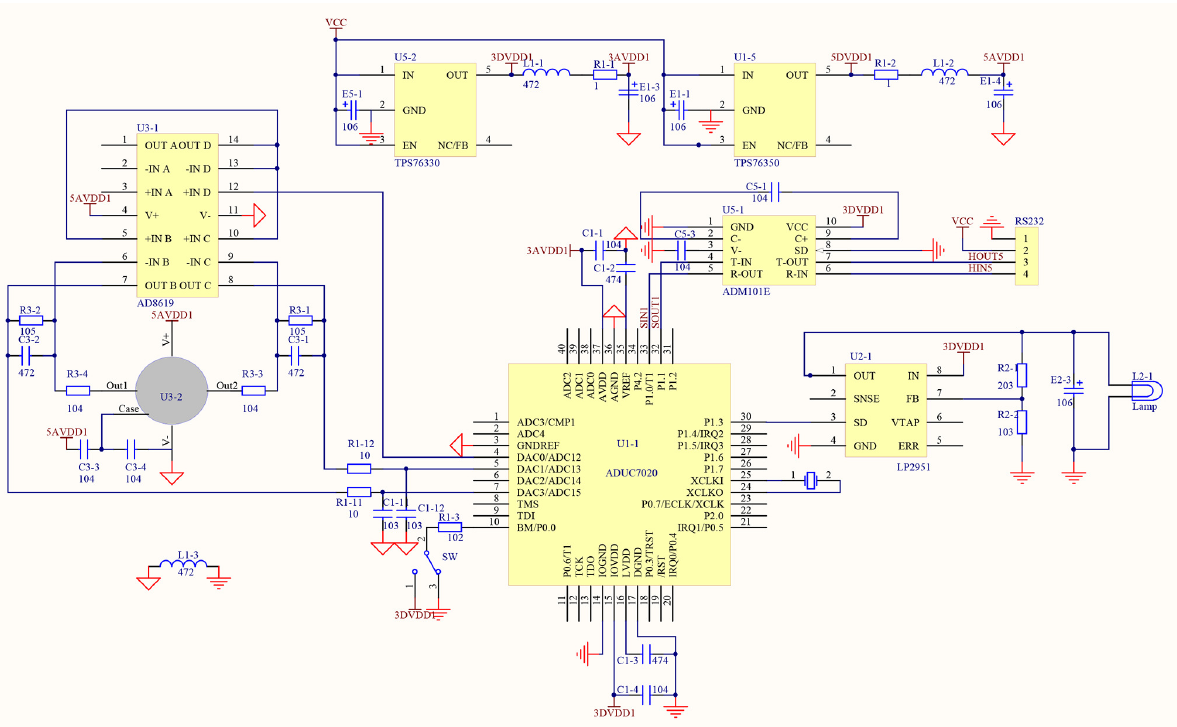
Figure 2. Circuit schematics of sensor